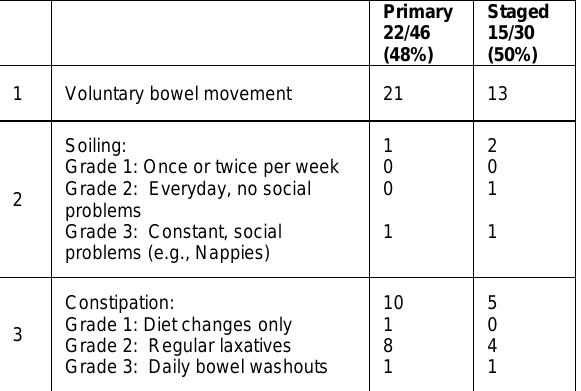
Table 4: Main results from the follow-up